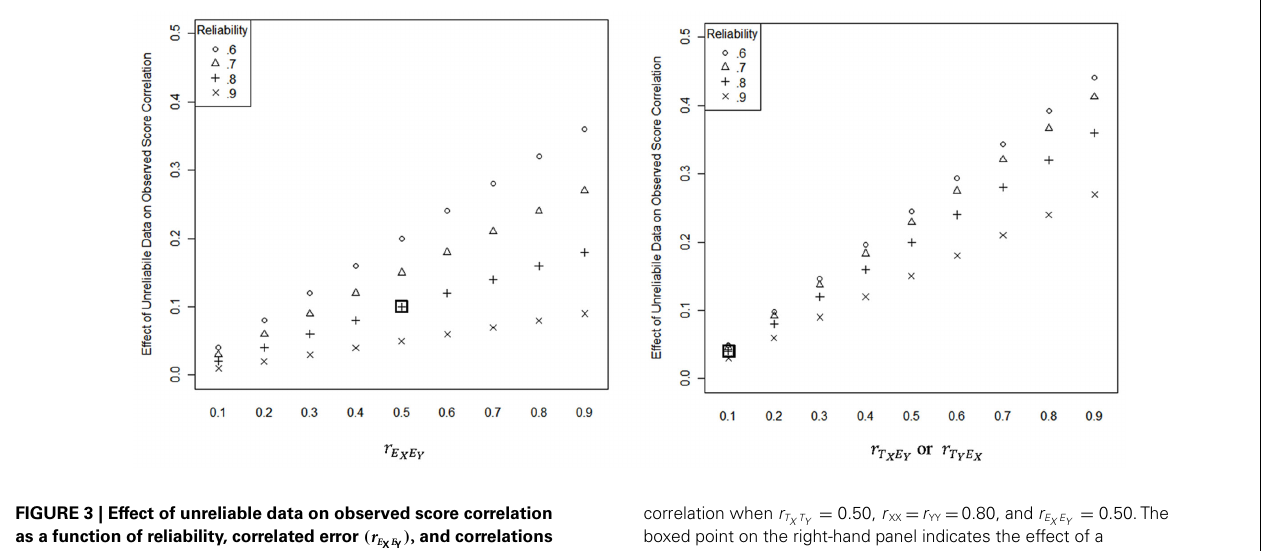
FIGURE 3 | Effect of unreliable data on observed score correlation as a function of reliability, correlated error ( r E between true and error scores ( r T e XX = e YY = 1 − reliability . The boxed point on the left-hand panel indicates the effect of correlated error on an observed score